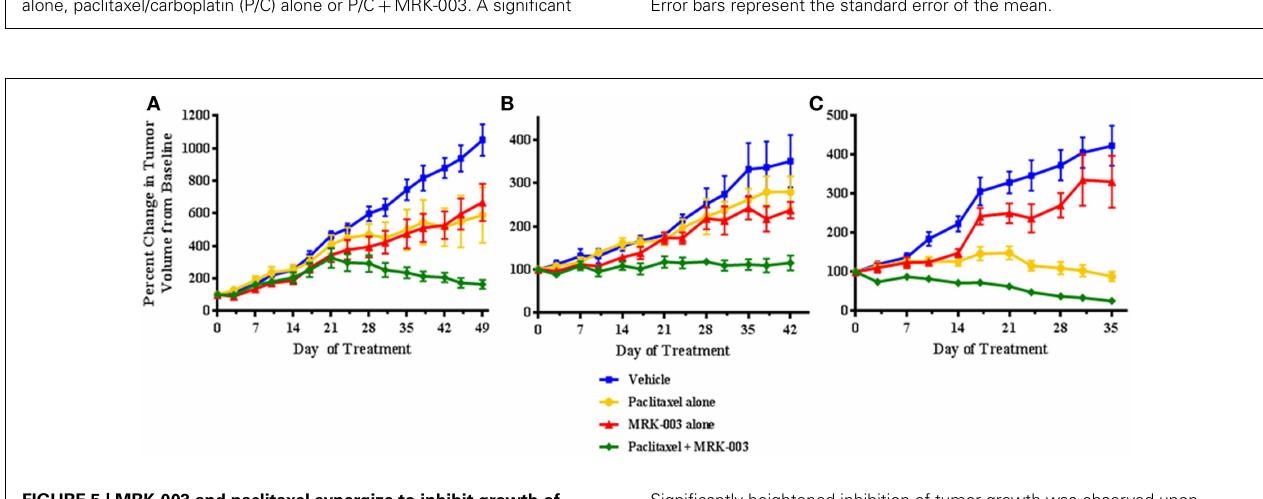
FIGURE 5 | MRK-003 and paclitaxel synergize to inhibit growth of platinum-resistant ovarian tumors .Three independent cohorts of mice bearing xenografts derived from clinically platinum-resistant serous ovarian cancer were randomly divided into four groups. Each group received vehicle, paclitaxel alone, MRK-003 alone or paclitaxel + MRK-003.